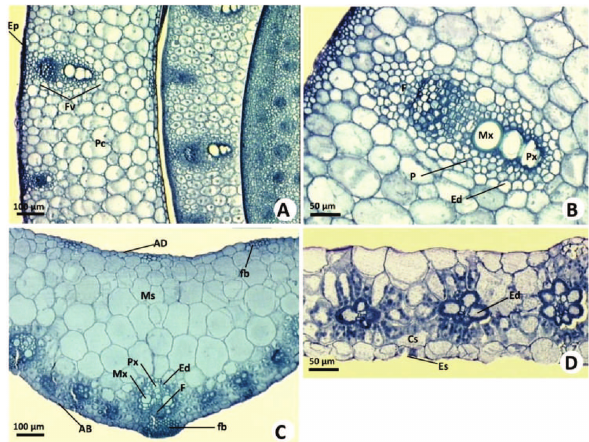
Figure 6. Transversal section of a leaf of corn grown in a nutrient solution containing 75 µmol L -1 Al.